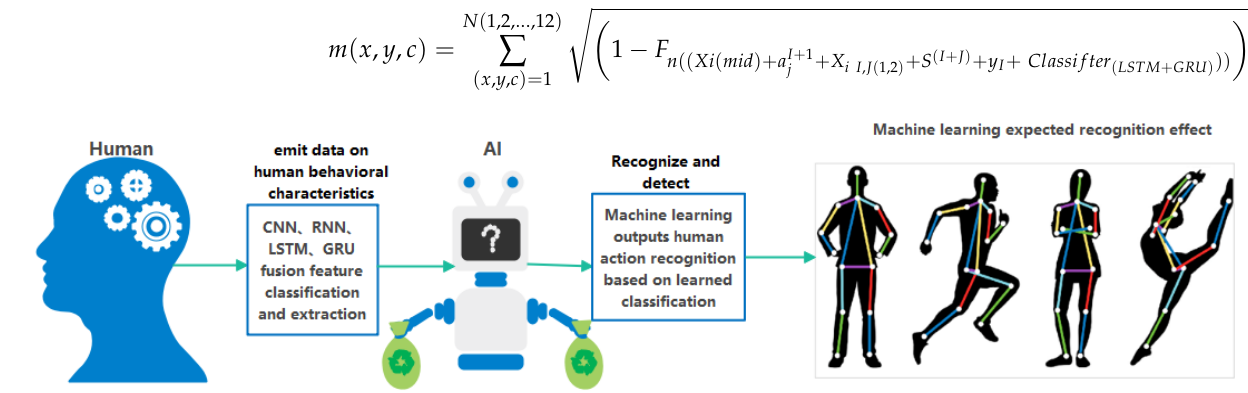
Figure 20. Model diagram of machine learning detection results.